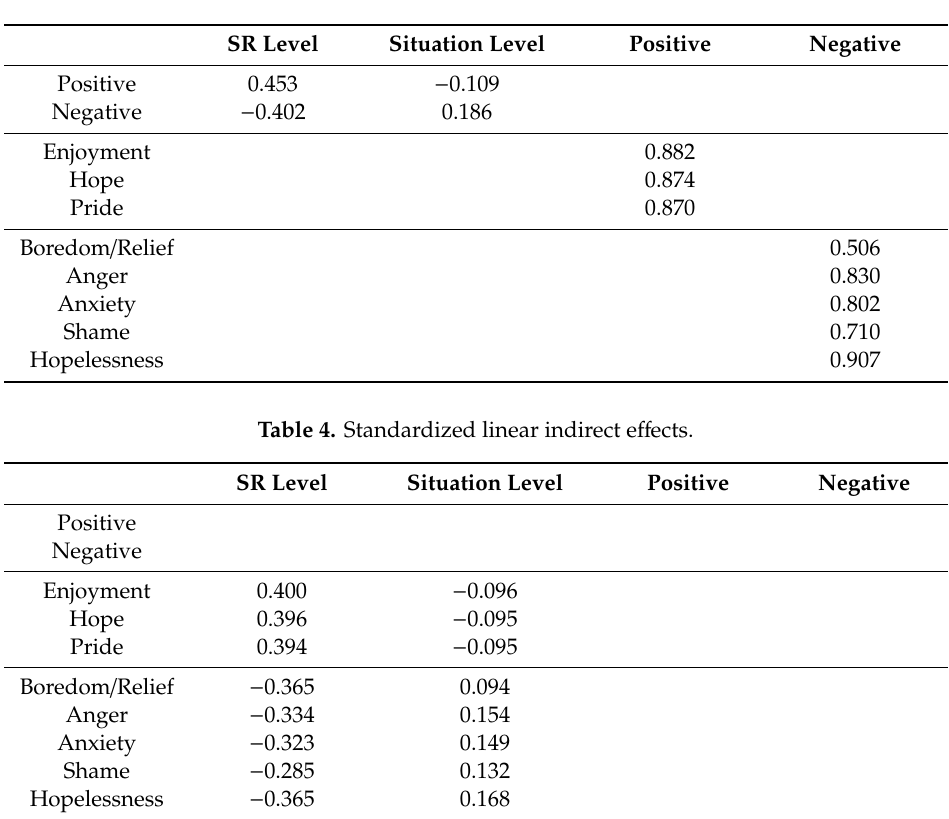
Table 3. Standardized linear direct e ff ects.